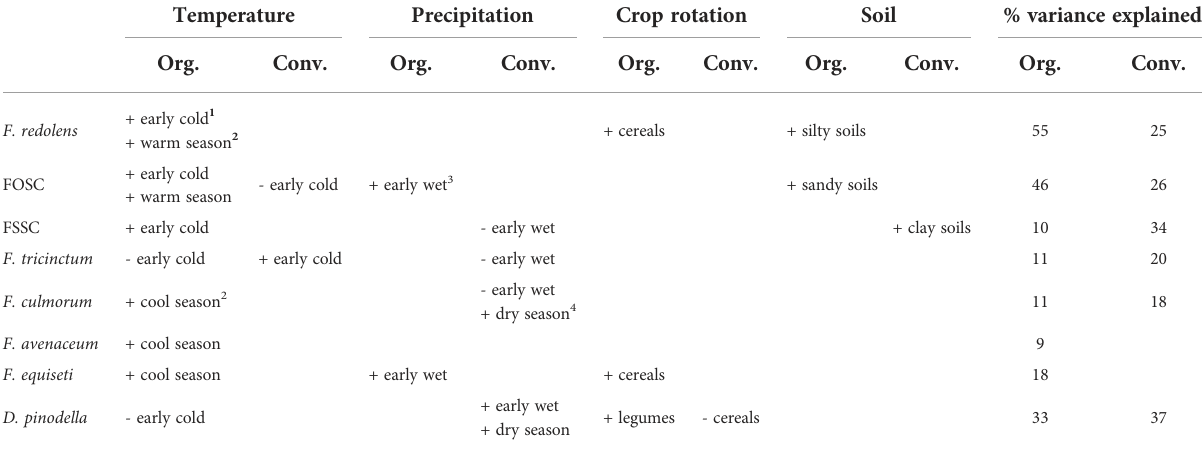
TABLE 6 Summary of the path analysis results showing the main environmental and cropping history factors affecting abundance (isolation frequencies) of major fungal species in roots of organically (Org.) and conventionally (Conv.) grown faba beans. Temperature